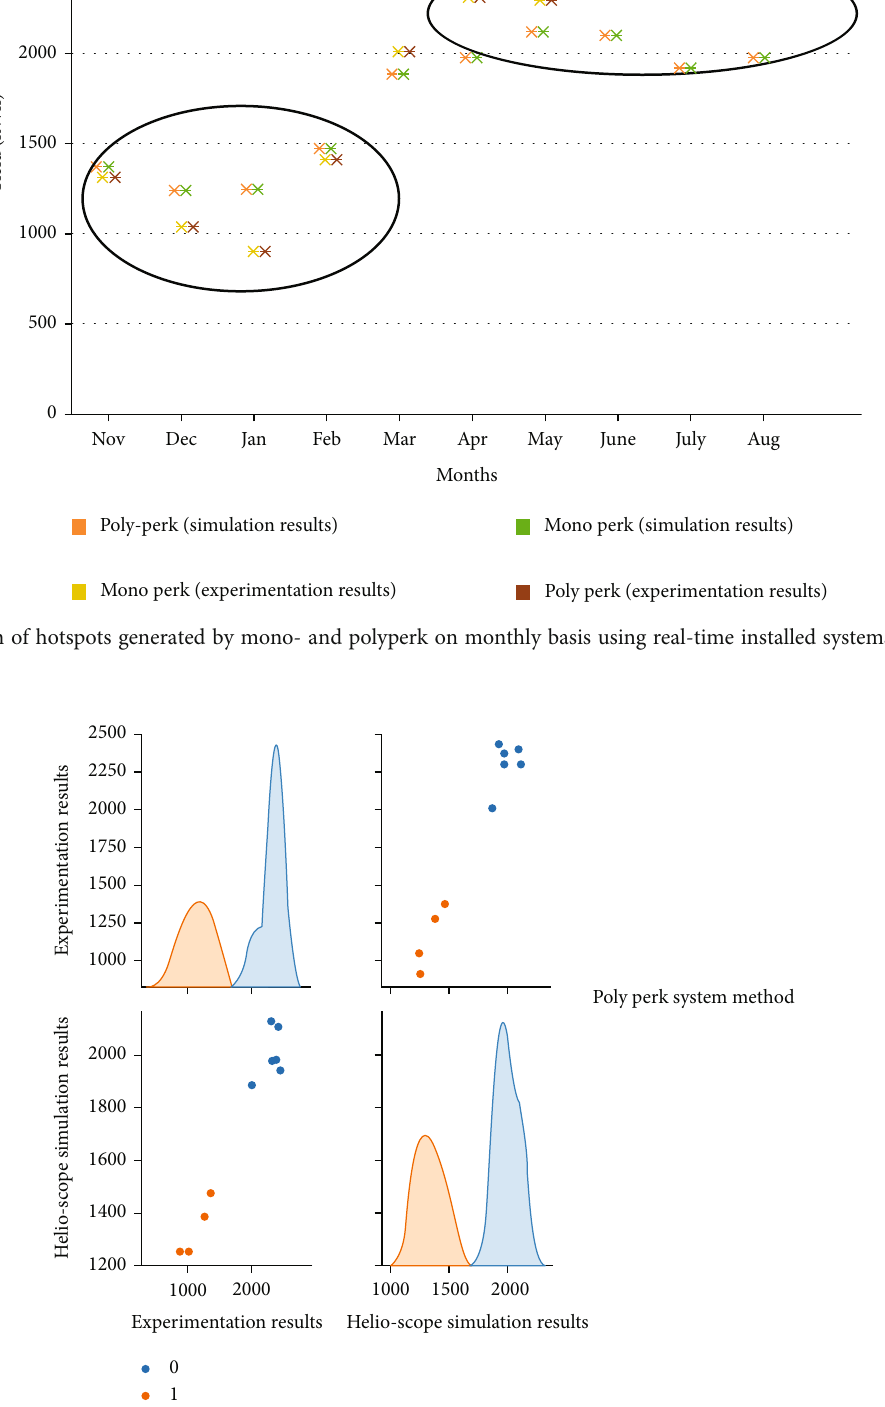
Figure 5: Peak form data of experimental and simulation results for polycrystalline material energy systems (1, simulation; 0,